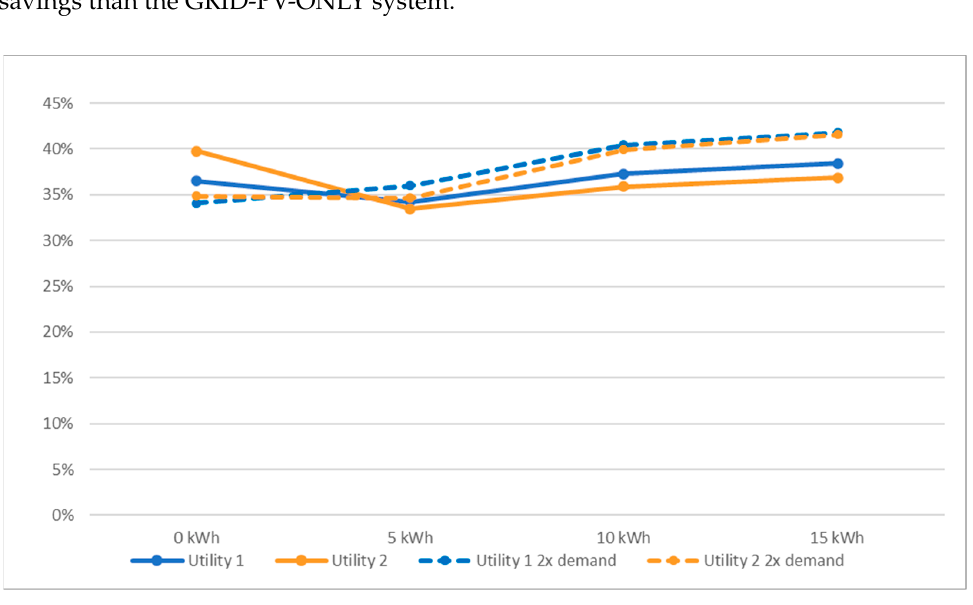
Figure 12. Annual net savings with and without doubled demand charges, compared to GRID- ONLY.